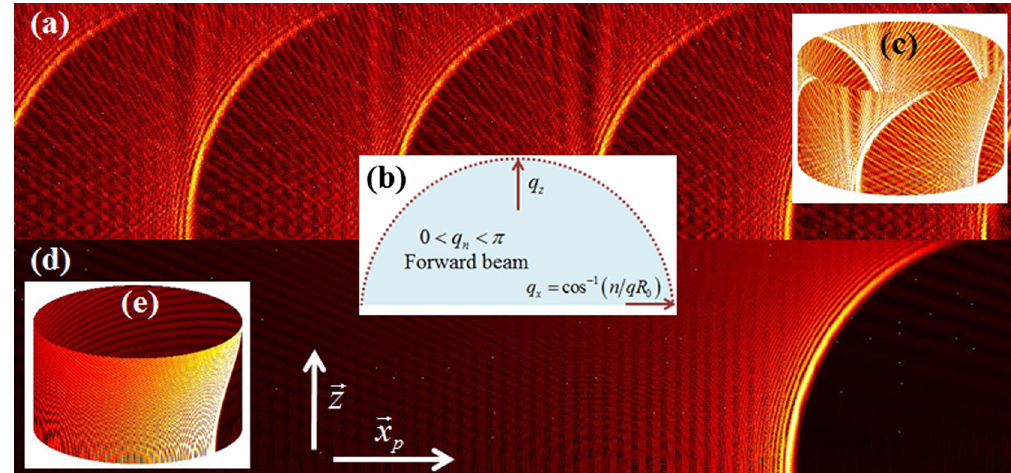
FIG. 2. Periodic accelerating beams constructed from discrete spatial frequencies as they propagate on various cylinders. This wave packet travels along circular trajectories while bending to very large nonparaxial angles. (a) The wave packet consists of several parallel 1 . (b) Schematic beams that depend on the initial choice of D ; only every fifth spectral function is populated, each with D 5 n n ¼ illustration of the periodic accelerating beam in k space. The beam is constructed from discrete spatial frequencies that reside in a half- circle in k space. This beam is a superposition of only forward-propagating waves. (d) Periodic accelerating beam on a cylinder, 1 ). (c),(e) The beams from (a) and (d) propagating on a surface of a displaying a single intense main lobe ( D n ¼